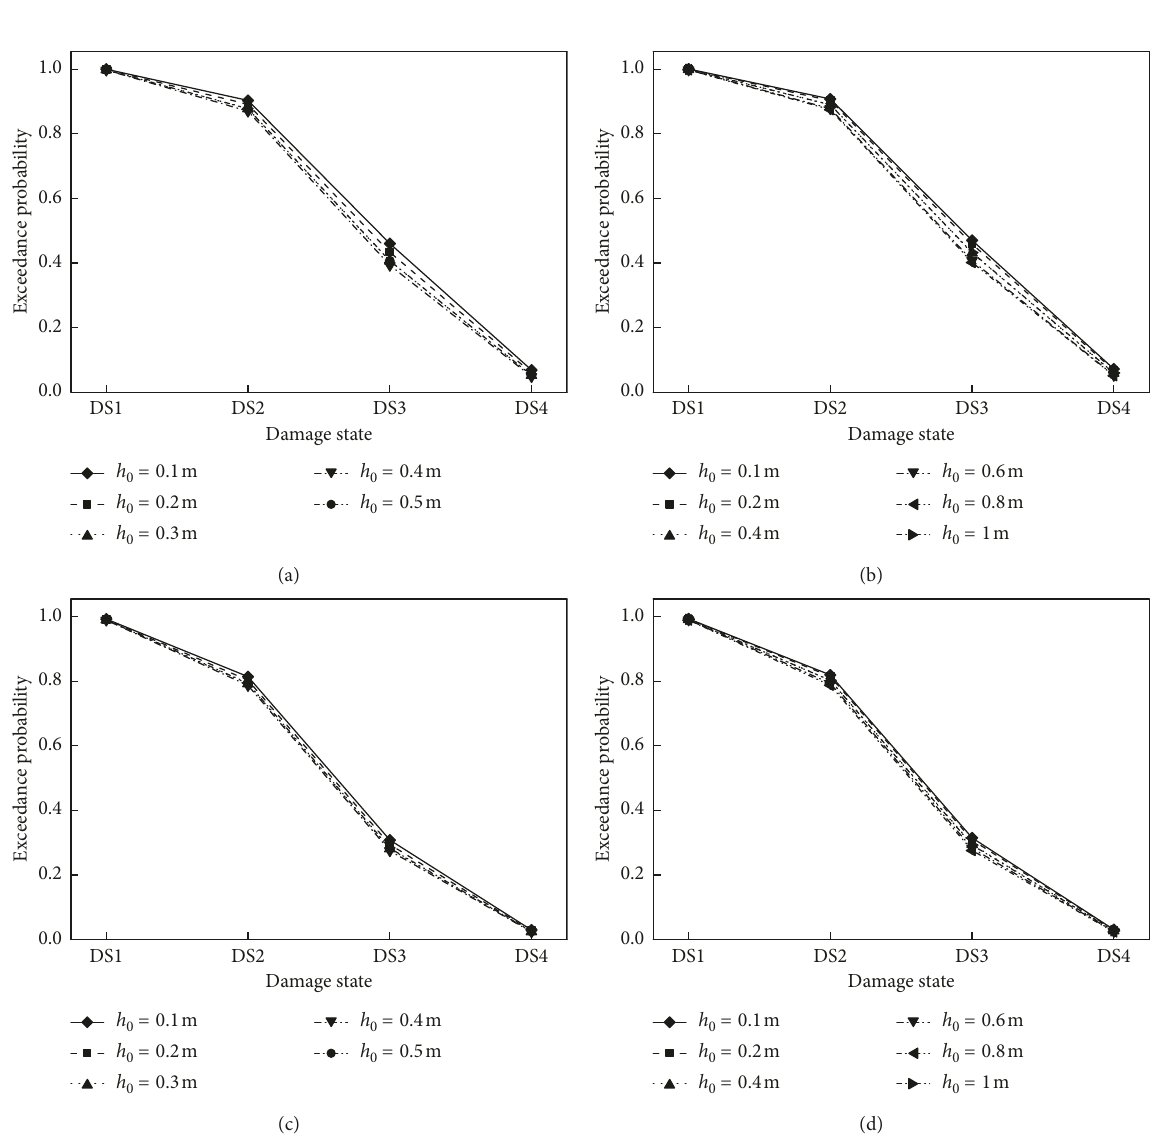
0.8 g (the horizontal ordinates (cid:31) 1 , h . 5m, 0.005, r 0.0 m 1 (cid:31) 0 (cid:31) (cid:31) 1 , h . 5m, C 0.005, r 0.0m 100kN s/m. (d) μ 0 0.005, − 1 (cid:31) 0 (cid:31) (cid:31) (cid:31) · (cid:31) −